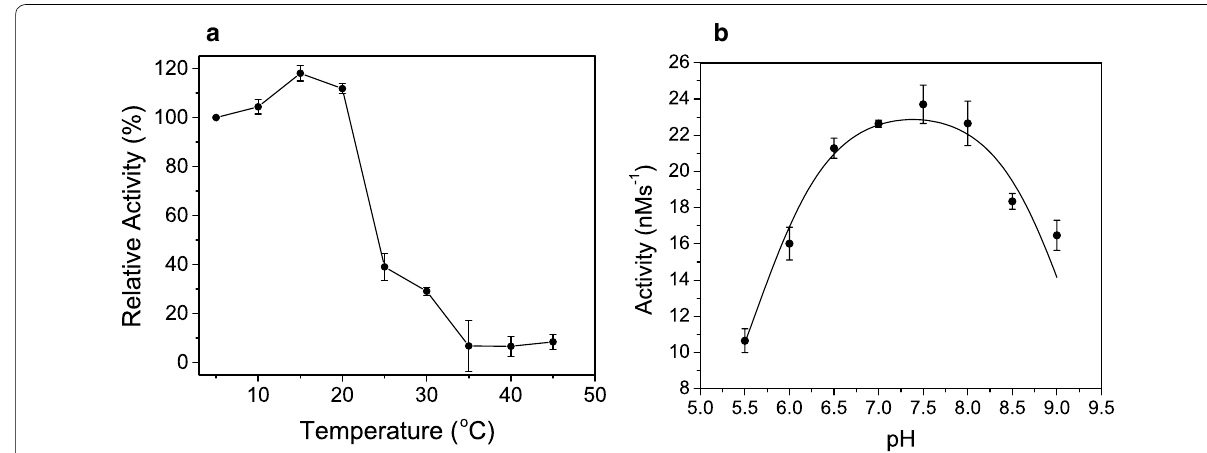
Fig. 5 a Residual activity of GSTACMO following a 1 h pre-incubation of the enzyme at various temperatures. b pH-dependence of GSTACMO activity. Reactions were performed as described in “Materials and methods”